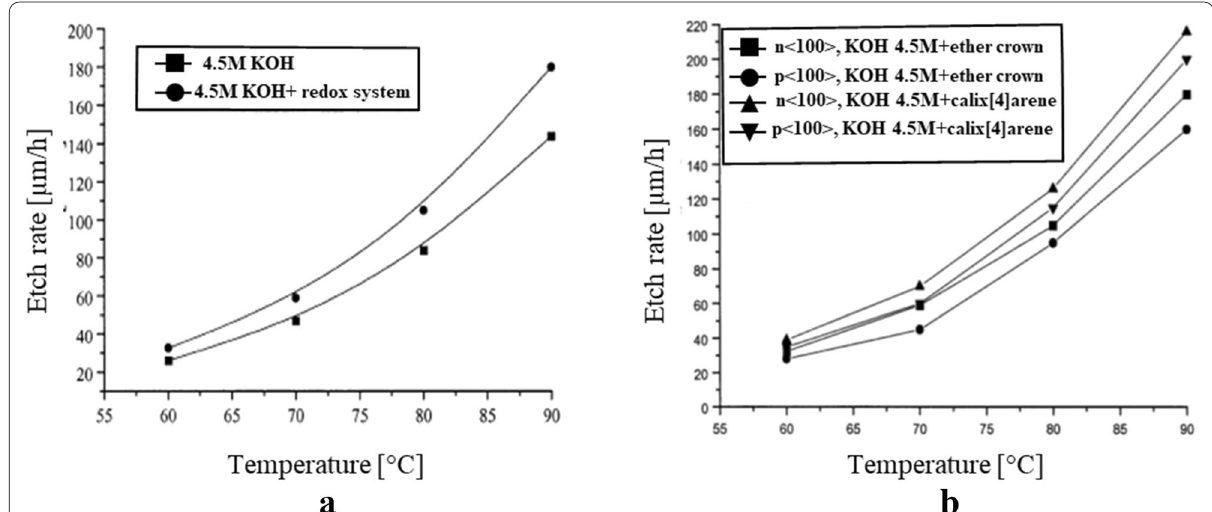
Fig. 22 Etch rate of Si{100} in 4.5 M KOH with a redox (K 3 [Fe(CN) 6 ] 0.1 M, K 4 [Fe(CN) 6 ].3H 2 O 0.1 M, KNO 3 0.1 M) and b complexants (ether-crown, calix[4]arenes) [52], © 1999,